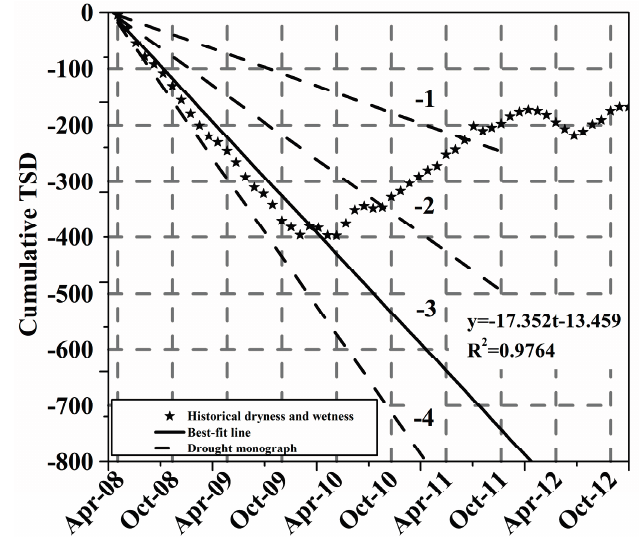
Figure 6. Total storage deficit (TSD, %) for the arid land during 2003–2012.